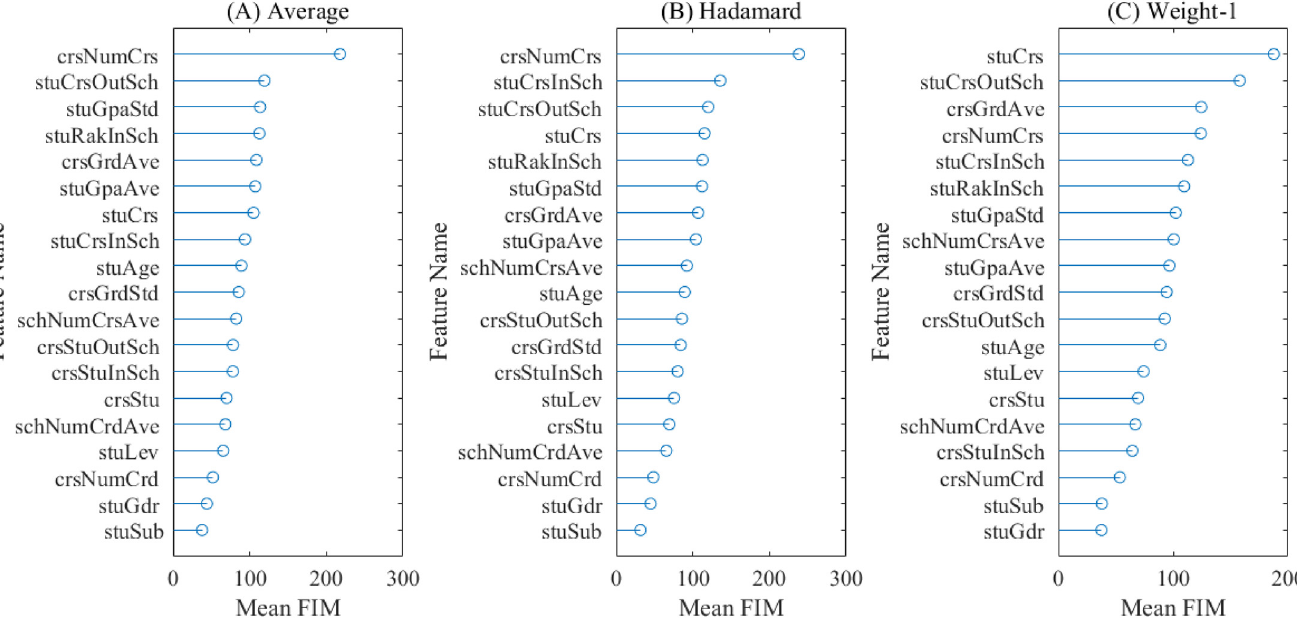
Fig 7. Mean FIMs for the three contrast models. (A) Average. (B) Hadamard. (C)